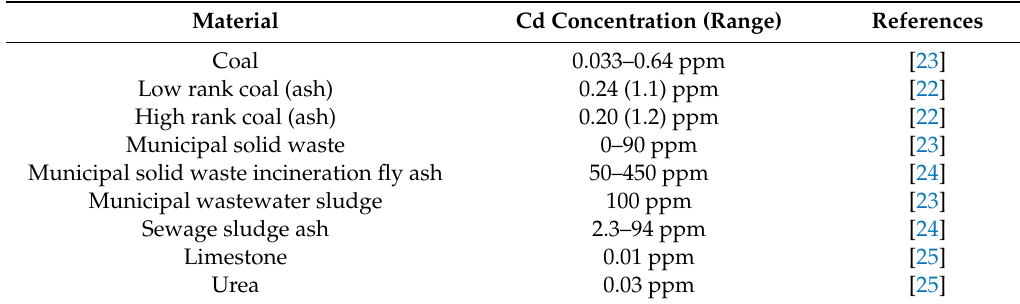
Table 1. Cadmium levels in target